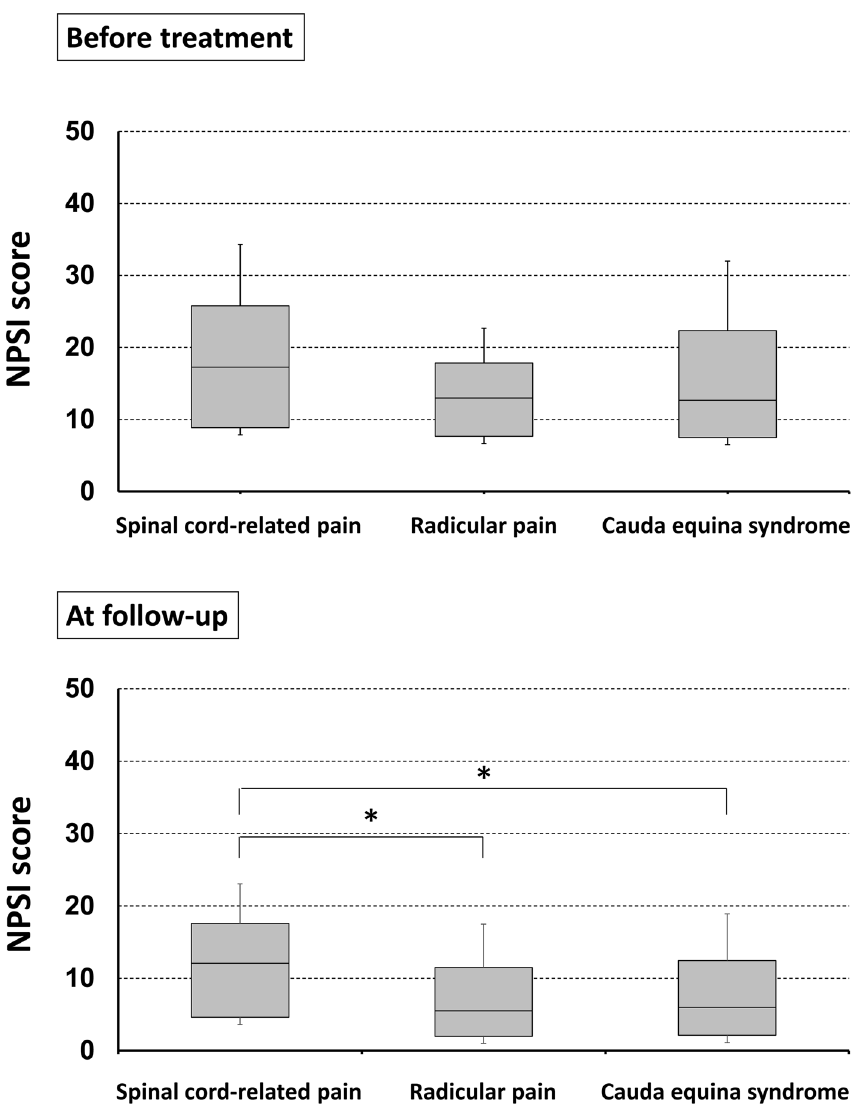
Figure 1. Neuropathic pain system inventory (NPSI) scores in patients with spinal cord-related pain, radicular pain, and cauda equina syndrome. Moderate pain remained at 12.5 points, even at follow-up, in patients with spinal cord-pain. *p<0.05. NSPI Neuropathic Pain Symptom